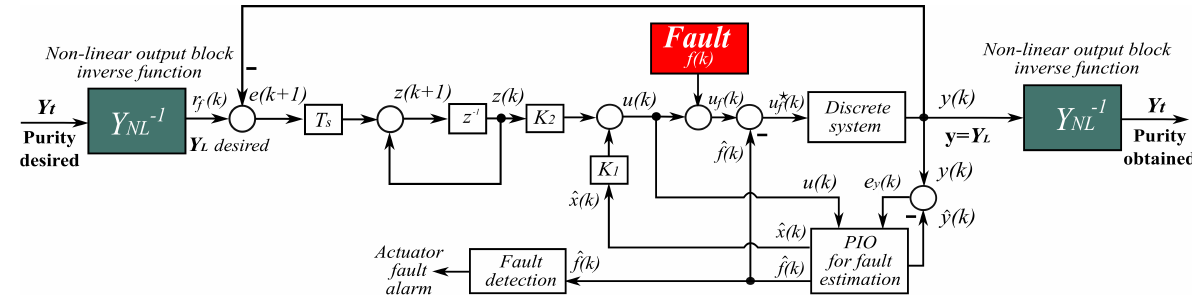
Figure 10. Active FTC scheme applied to Hammerstein − Wiener